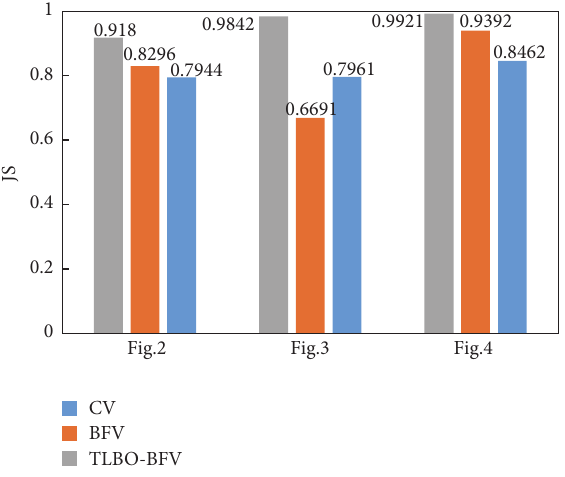
Figure 5: JS of methods.